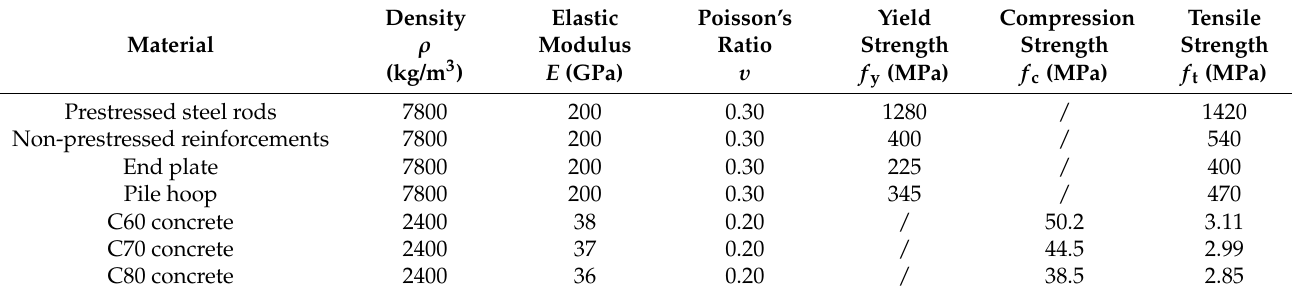
Table 2. Material parameters.